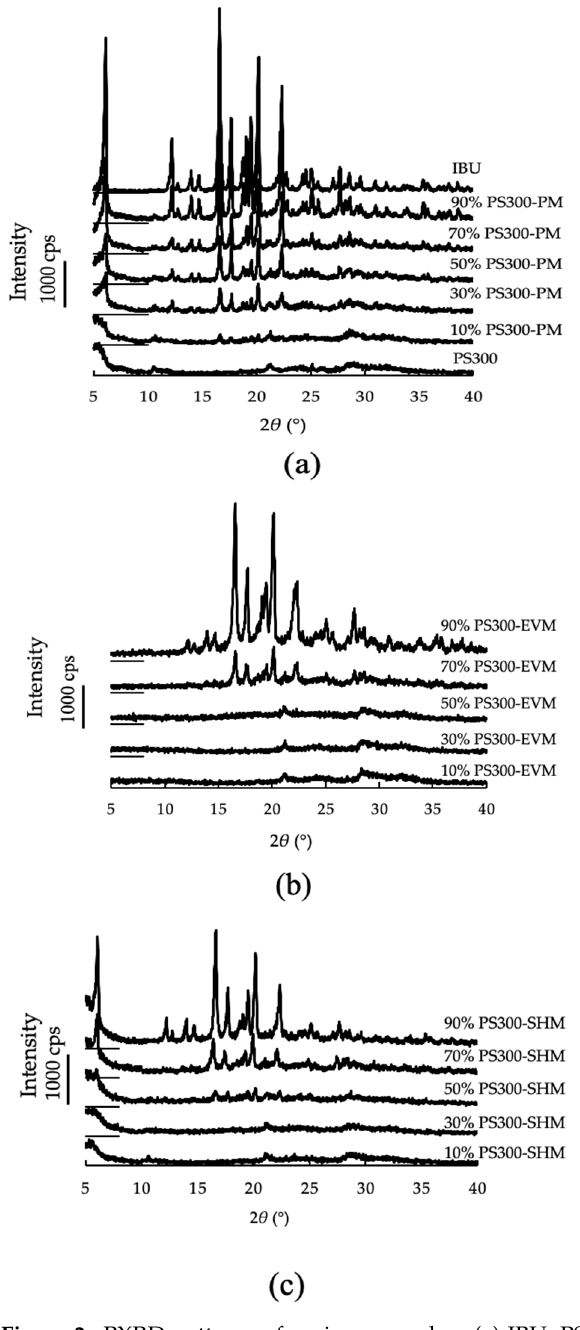
Figure 2. PXRD patterns of various samples. ( a ) IBU, PS300, and PMs of various mixing ratios; ( b ) EVMs of various mixing ratios; ( c ) SHMs of various mixing ratios.